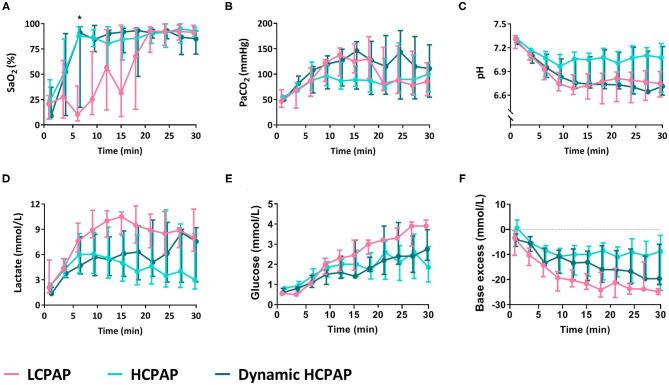
Blood gas parameters. Median (Q1–Q3) percentage of oxygen saturation of arterial blood (SaO2, A), partial pressure of carbon dioxide in arterial blood (PaCO2, B), pH (C), lactate (D), glucose (E), and base excess (F) in lambs receiving LCPAP vs. HCPAP vs. dynamic HCPAP in the first 30 min after birth (time 0 = cord clamping). All parameters were compared over time using linear mixed-effect regression models. One asterisk (*) indicates the significant difference between the LCPAP vs. HCPAP group.